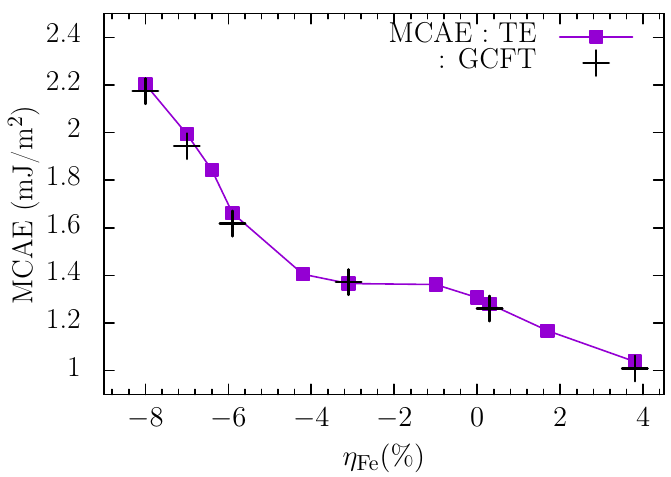
Figure 5. MCAE in structure-II as a function of strain. The square and plus symbols specify the data from the total energy (TE) and GCFT schemes,